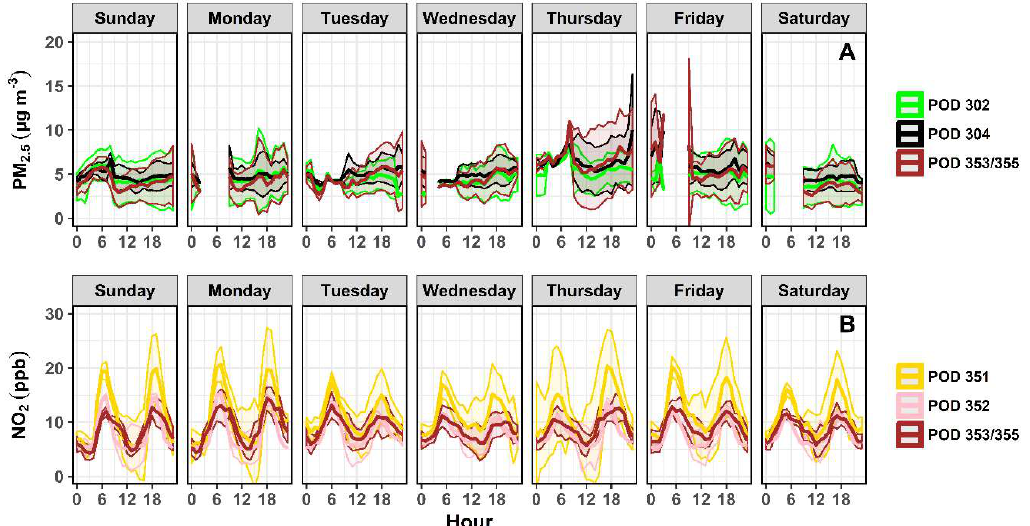
Figure 8. The 1 h average PM 2.5 ( A ) and NO 2 ( B ) time-aligned concentrations were binned hourly on a weekly basis to explore the spatial relationship between CSAM locations as a function of time. Shading indicates the standard deviation binned hourly. Gaps in PM 2.5 concentrations during certain periods indicate either 1 or more sensors were non-responsive.